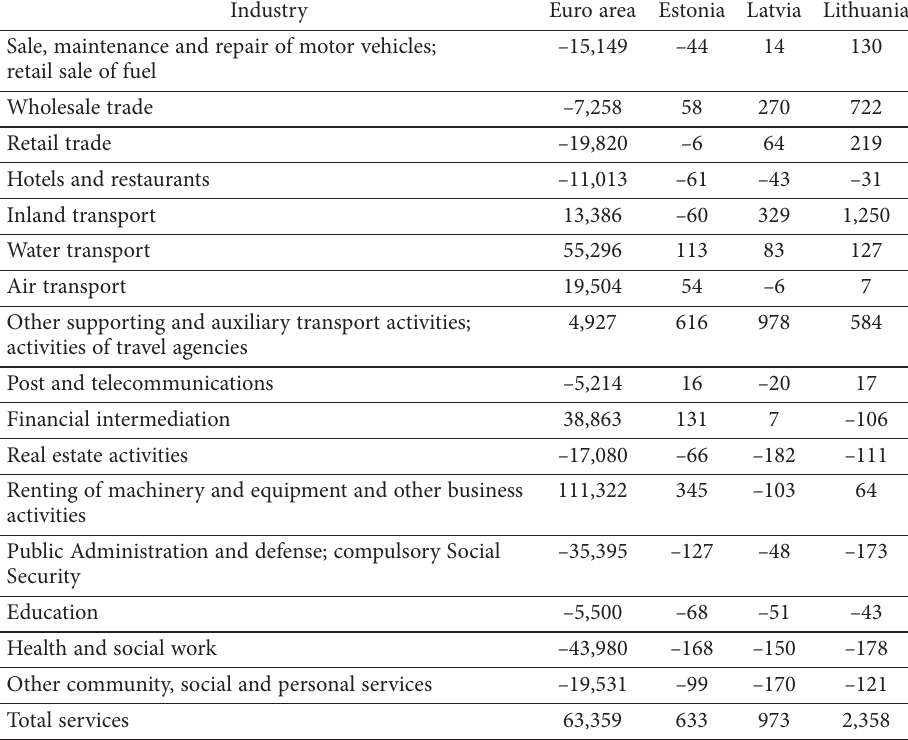
Table 4. Service content of net trade in intermediate services in the Euro area and the Baltic States, 2011 (million US$)